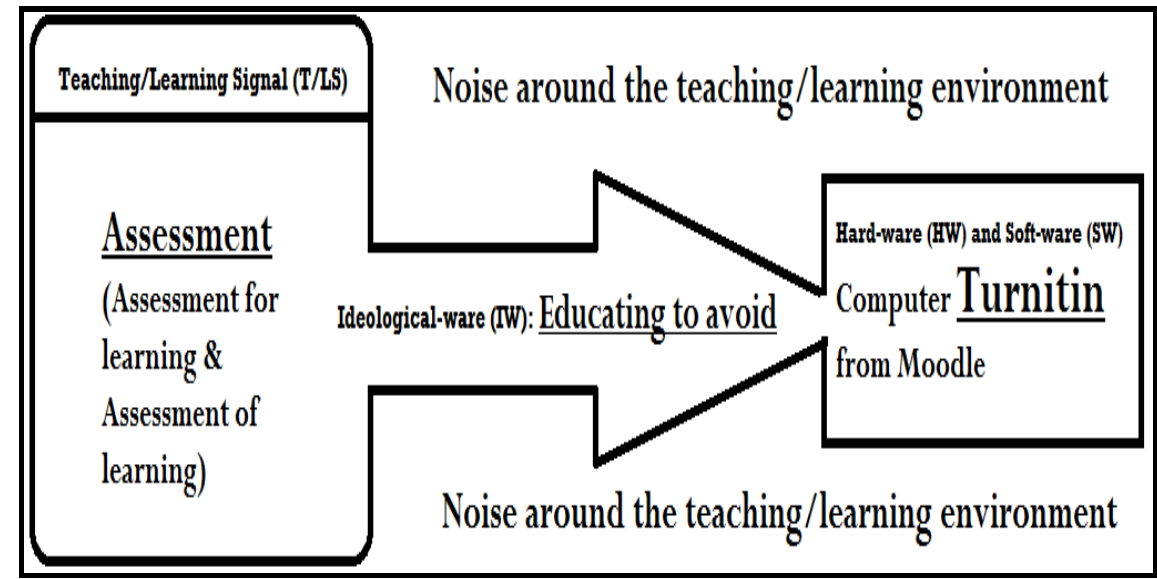
Figure 2 Assessment, Educating to avoid and Turnitin framework